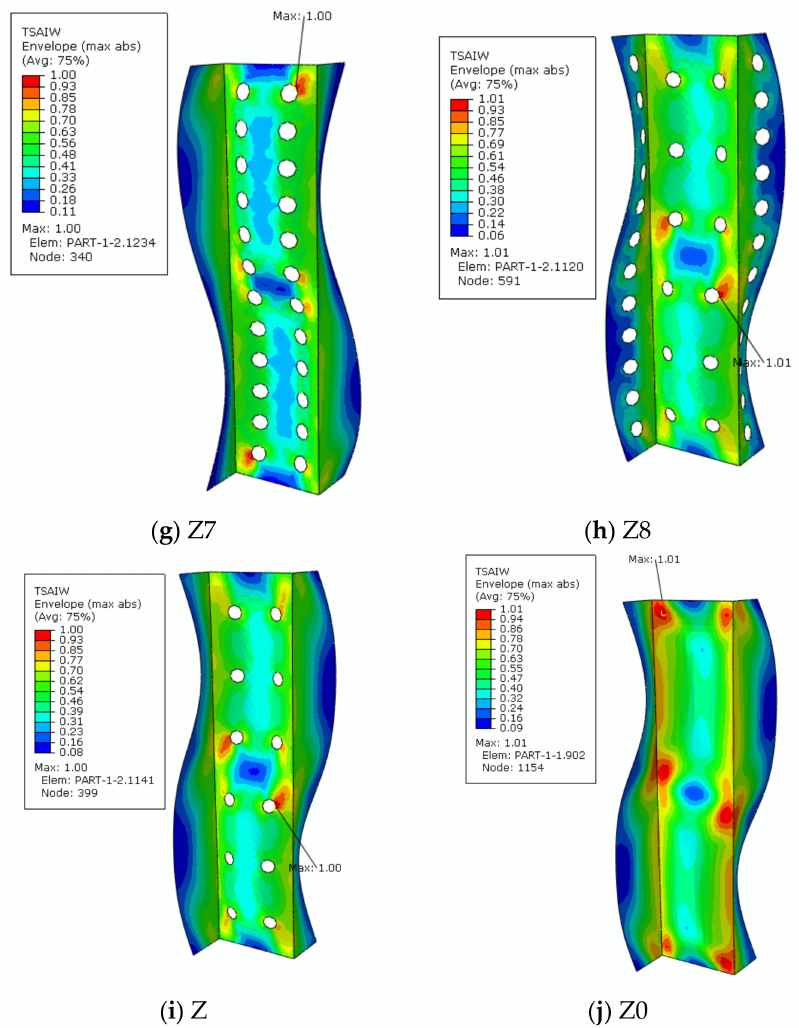
Figure 8. Maps of the Tsai-Wu critical parameter: ( a ) Z1 profile, ( b ) Z2 profile, ( c ) Z3 profile, ( d ) Z4